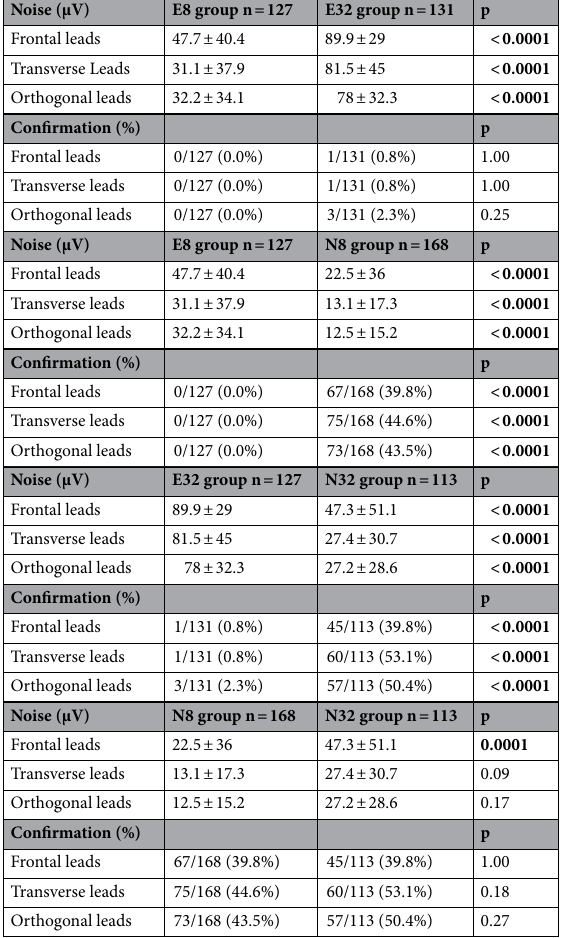
Table 6. Noise values and confirmation during peak exercise, according to set of leads in the different groups. Noise values are expressed as mean and standard deviation. Groups: E8 = Ellestad factor 1/8; E32 =